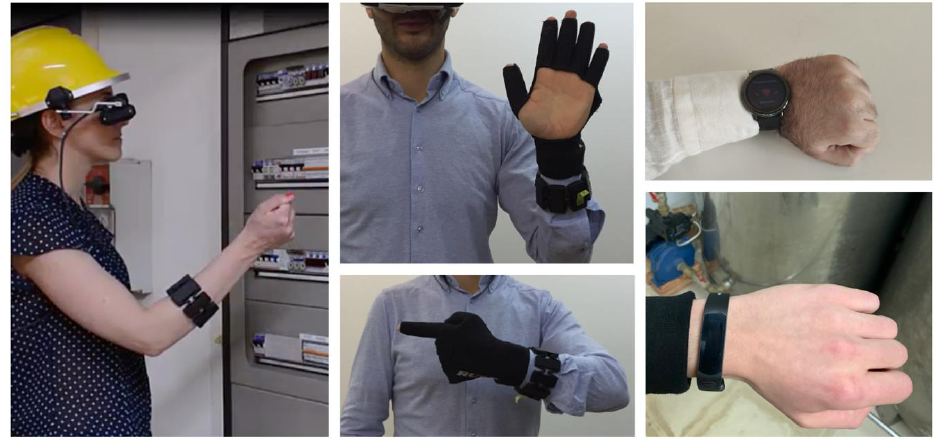
Figure 9. Example of wearable technology—from left to right, wristbands, gloves, smartwatches— augmenting workers’ perception capabilities.